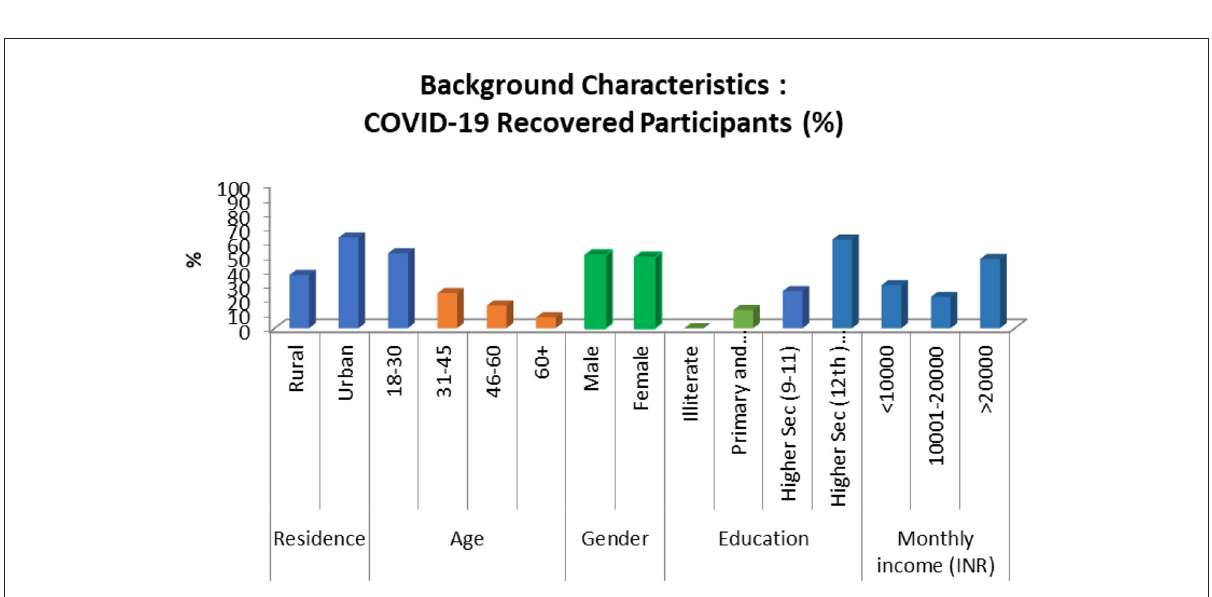
FIGURE2 Socio-demographic characteristics of COVID-19 recovered